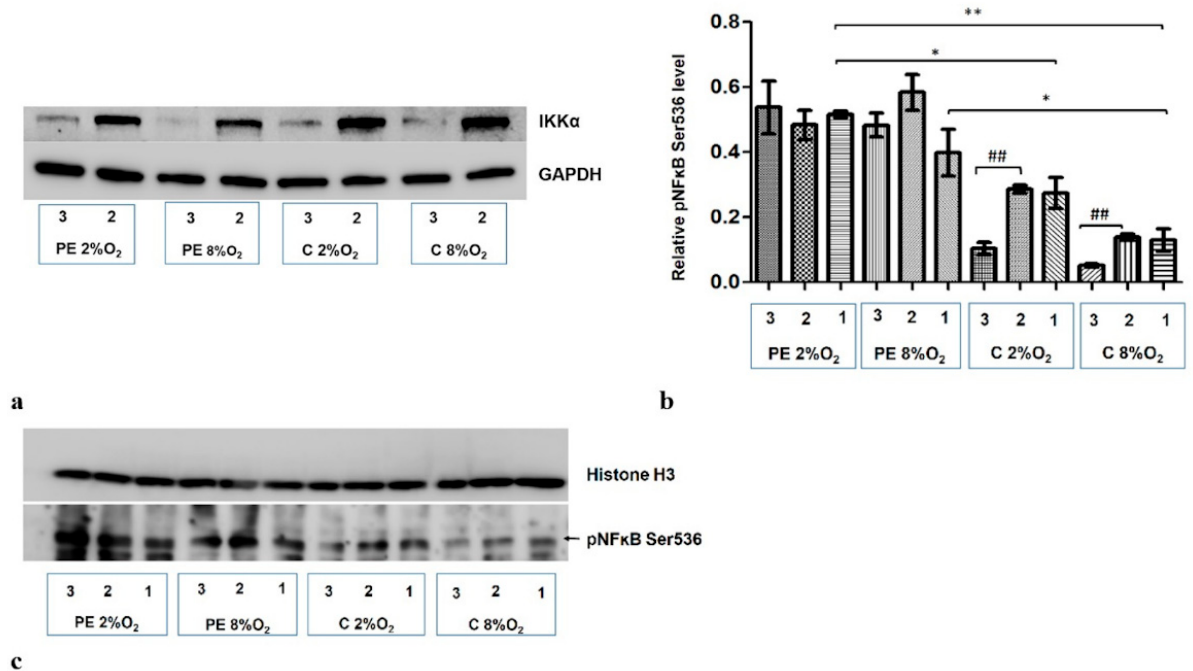
Figure 4. Western blot results. ( a ) inhibition of IKK α by targeted siRNA; Western blot results for the cytoplasmic fraction ( b ) the differences in relative pNFkB Ser536 fraction to Histone H3 in nucleus of HTR8/SVneo cells. Cells were cultured for 96 h in hypoxic or normoxic conditions with medium containing 1% serum from preeclamptic or normotensive women. For the first 48 h, the cells were incubated only with medium containing maternal serum. After 48 h and 72 h, the cell medium was supplemented with the following factors: none, i.e., cells without siRNA (1), non-targeting siRNA (2) and siRNA targeted against mRNA coding for IKK α (3). The relative level of pNFkB Ser536 compared to Histone H3 in the nuclear fraction was analyzed. Values are presented as mean ± SEM; ( n = 3 experiments). The difference in pNFkB Ser536 level between cells stimulated by negative and targeted siRNA was compared using Student’s t -test; ## p < 0.01. The difference in pNFkB Ser536 level between the four culture types (i.e., oxygen tension and serum type) which were not stimulated with siRNA were analyzed by ANOVA with the Bonferroni post hoc test; * p < 0.05, ** p < 0.01. ( c ) Western blot results for the nuclear fraction.